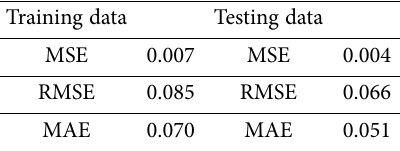
Table 5. Performance measures (DEA-GEP) Training